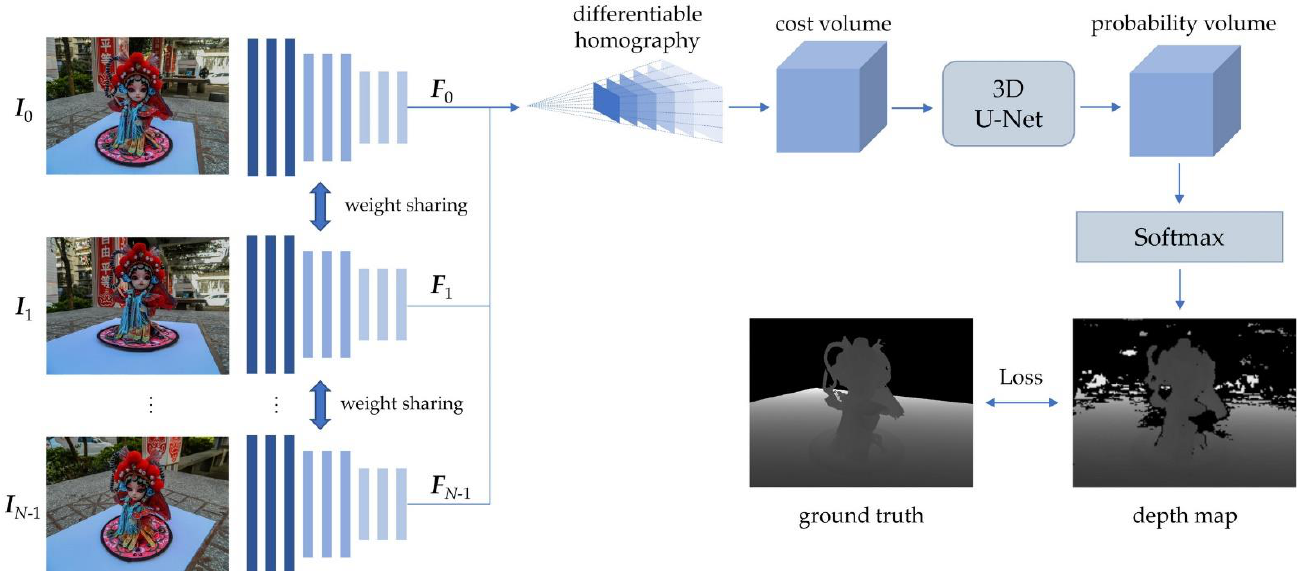
Figure 8. Network structure of CES-MVSNet.